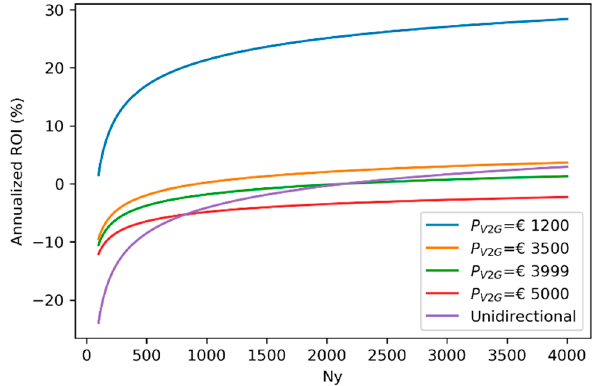
Figure 6. ROI of entities owning a network of unidirectional and V2G EVSE in function.